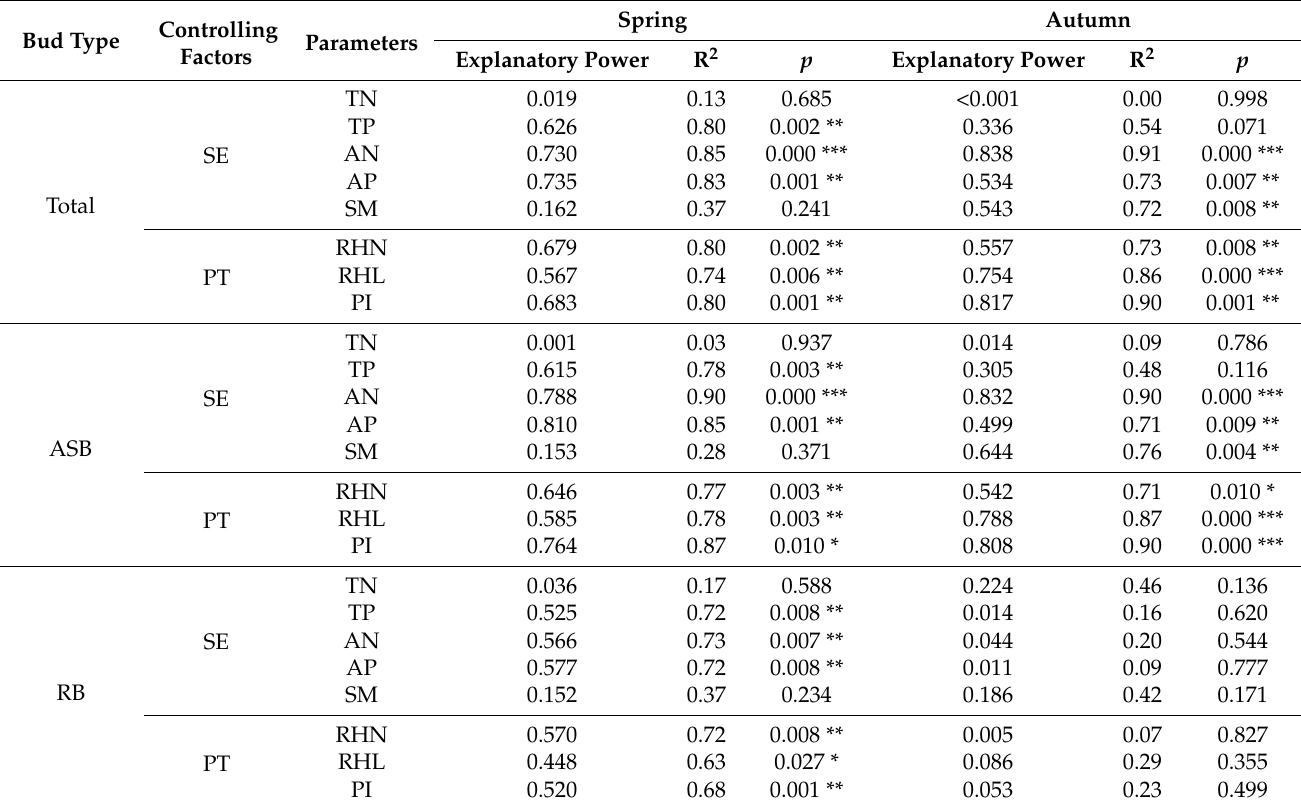
Table 2. The explanatory power and regression analysis of impact factors on the number of different types of buds in spring and autumn. The explanatory power indicates how much bud bank variation can be explained by controlling factors.